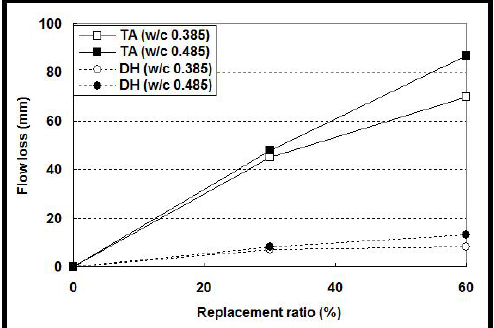
Figure 4. Variation of flow with different replacement ratio of PA.